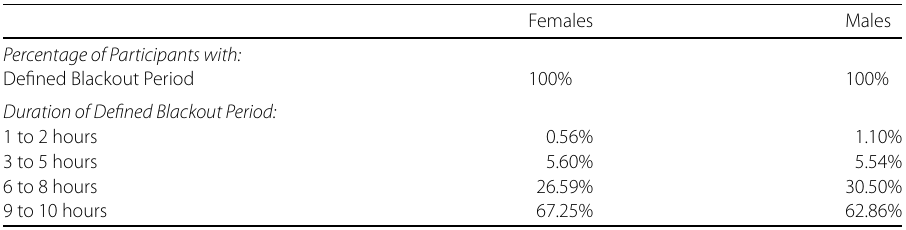
Table 4 Participant blackout periods